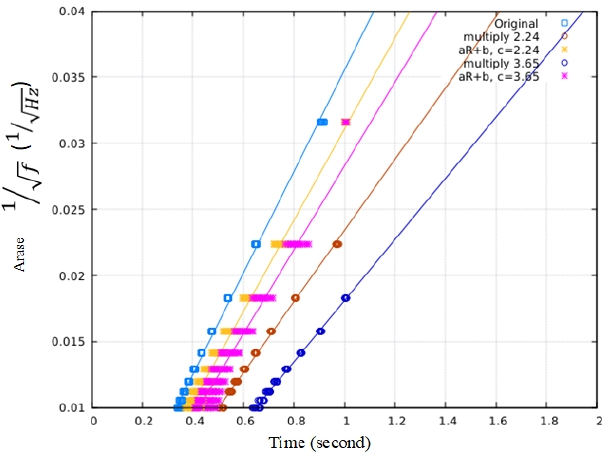
Figure 8. The calculated propagation time from the source point to the Arase location. Changing the electron density profile affects the propagation time and dispersion, as shown in Figure 8. The colored lines indicate the dispersion for each calculated propagation time. The light blue line indicates the propagation time using density (0) or without modification. The orange and dark blue lines indicate the propagation times modified by 𝑓(𝑟) = 𝑐 with 𝑐 as 2.24 and 3.65, respectively. Multiplying the density by a higher number slowed the propagation time and increased dispersion. Using Equation (5) to modify the density resulted in the yellow and purple lines, where 𝑐 = 2.24 and 𝑐 = 3.65 were used, respectively, with the same 𝑟 (cid:2868) = 1000 𝑘𝑚 + 𝑅 (cid:3006) and 𝑟 (cid:3040) = 2𝑅 (cid:3006) . The density at the lower al- titude was retained to ensure that the propagation time was not too slow or that the dis- persion was too large. Therefore, we can approach the desired dispersion characteristics by finding the appropriate free parameters in the modification functions and initial con- ditions. To satisfy the electron density at the observation satellite point, we set the c constant of Equation (6) using the ratio of the in situ electron density measurement from the Arase and from the reference electron density model at the same location. The electron density along the Arase trajectory can be derived from the upper hybrid resonance (UHR) fre- quency, measured using a high frequency analyzer (HFA) [31,32], a subsystem of the PWE. The DC magnetic field intensity is measured using the magnetic field experiment (MGF) [33]. By setting 𝑟 (cid:2868) to 1000 km from Earth’s surface, we then examined several ray paths changing the value of 𝑟 (cid:3040) that fits the dispersion characteristics and obtain 𝑟 (cid:3040) = 2𝑅 (cid:3006) . This result produced c = 2.24, a = 2.3 × 10 − 7 , and b = − 0.7011. The density changes are shown in Figure 9. In Figure 9 there are three plots (a), (b), and (c) that show the reference electron density profile, modified electron density using 𝑓(𝑟) = 𝑐 , and the one modified by Equation (6), respectively. We generated the density for all regions, but Figure 9d shows for a particular slice at the geographic coordinate of longitude 120 (cid:2925) and 9°. The horizontal axis shows the altitude in km, and the vertical axis shows the electron density in/m 3 with logarithm scale. The blue, orange, and yellow colors describe the electron density (0) or without modification, the modified electron density with constant c , and with Equation (6) at each altitude point, respectively. The electron density profiles at higher altitudes are all similar because the electron density is small. The density at the Arase location is shown with a purple triangle, which is ~ 3800 𝑐𝑚 (cid:2871) (cid:3415) .